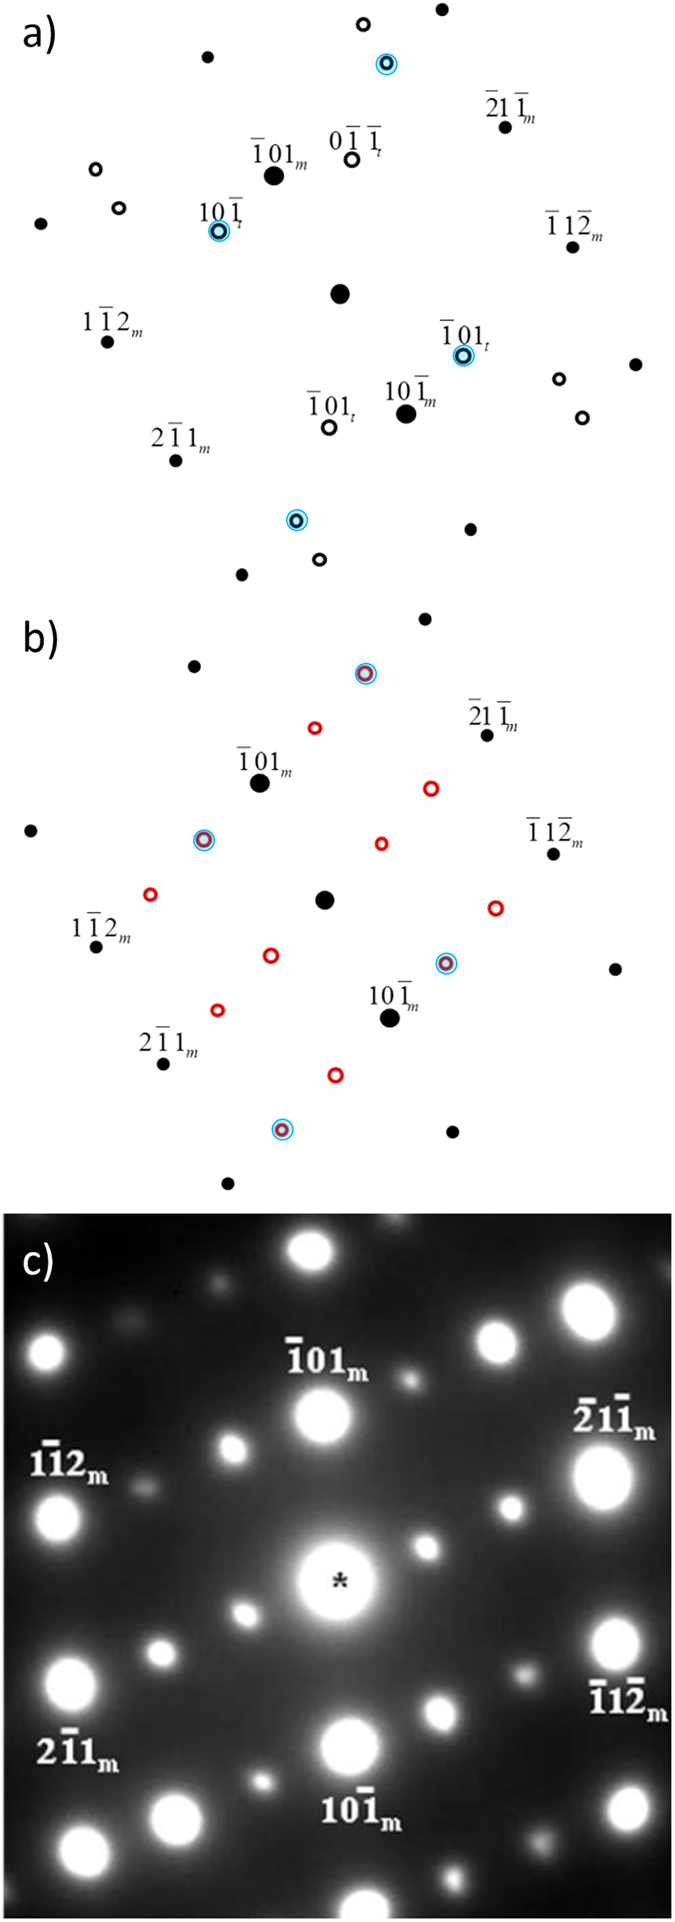
Foil normal [110] and zone axis [131] diffraction patterns.(a) Simulated twin spots (hollow circles and subscript t, (b) Simulated omega phase spots (red hollow circles). Larger blue circles correspond to shared diffraction spots. (c) Experimental diffraction pattern.